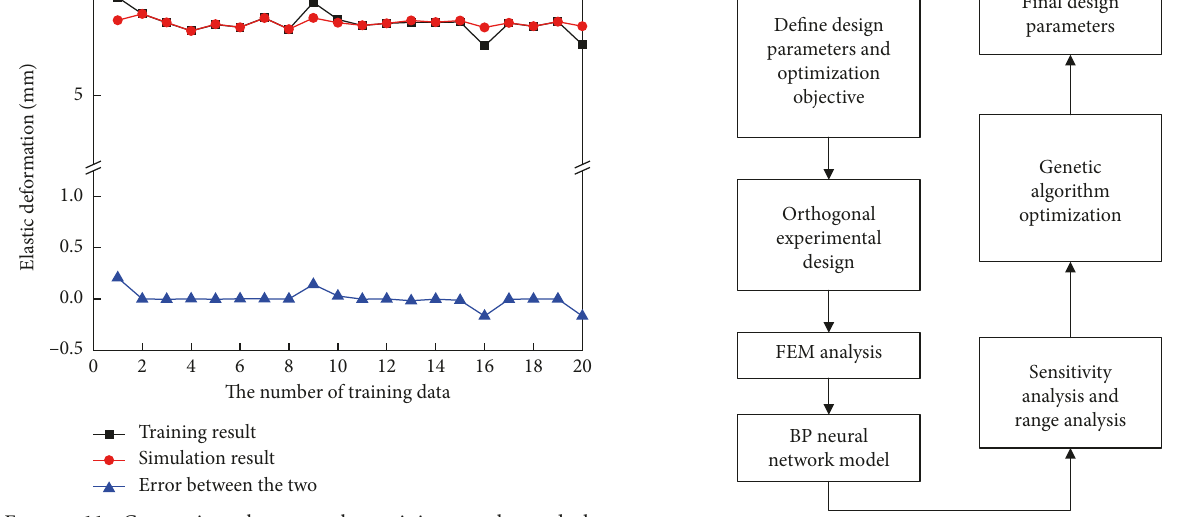
Figure 13: Optimization flow chart of the large vibrating screen.